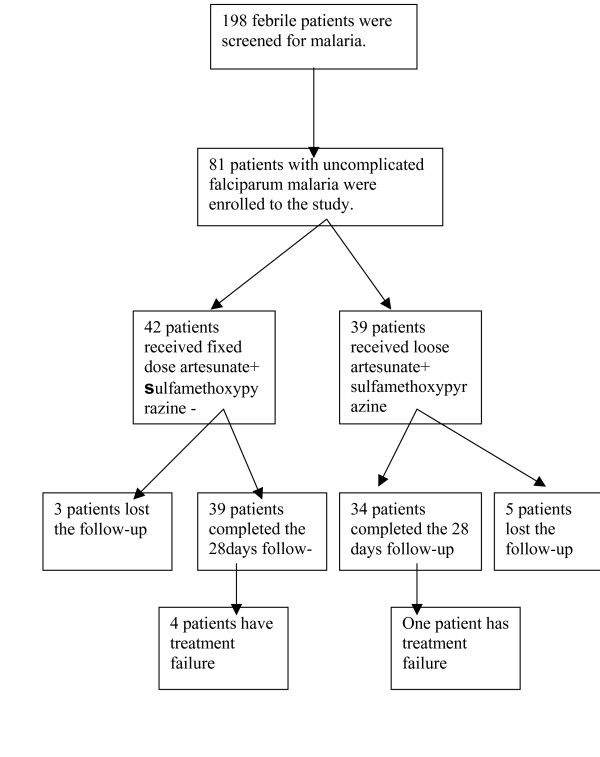
Trial profile, showing number of patients enrolled, treated and completing the 28 days of follow-up after the treatment with fixed or loose combinations of AS+SMP